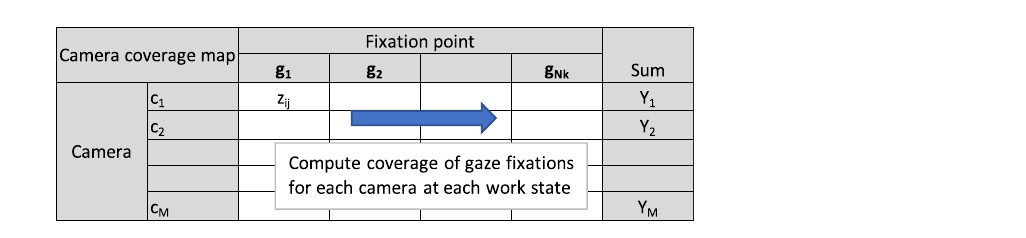
Figure 9. Illustration of camera coverage of gaze fixations at a work